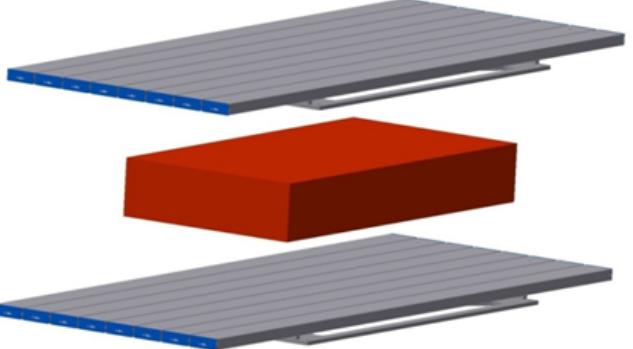
Figure 2. Two MCORD sections (grey) in coincidence mode. The setup used for testing another detector (red).